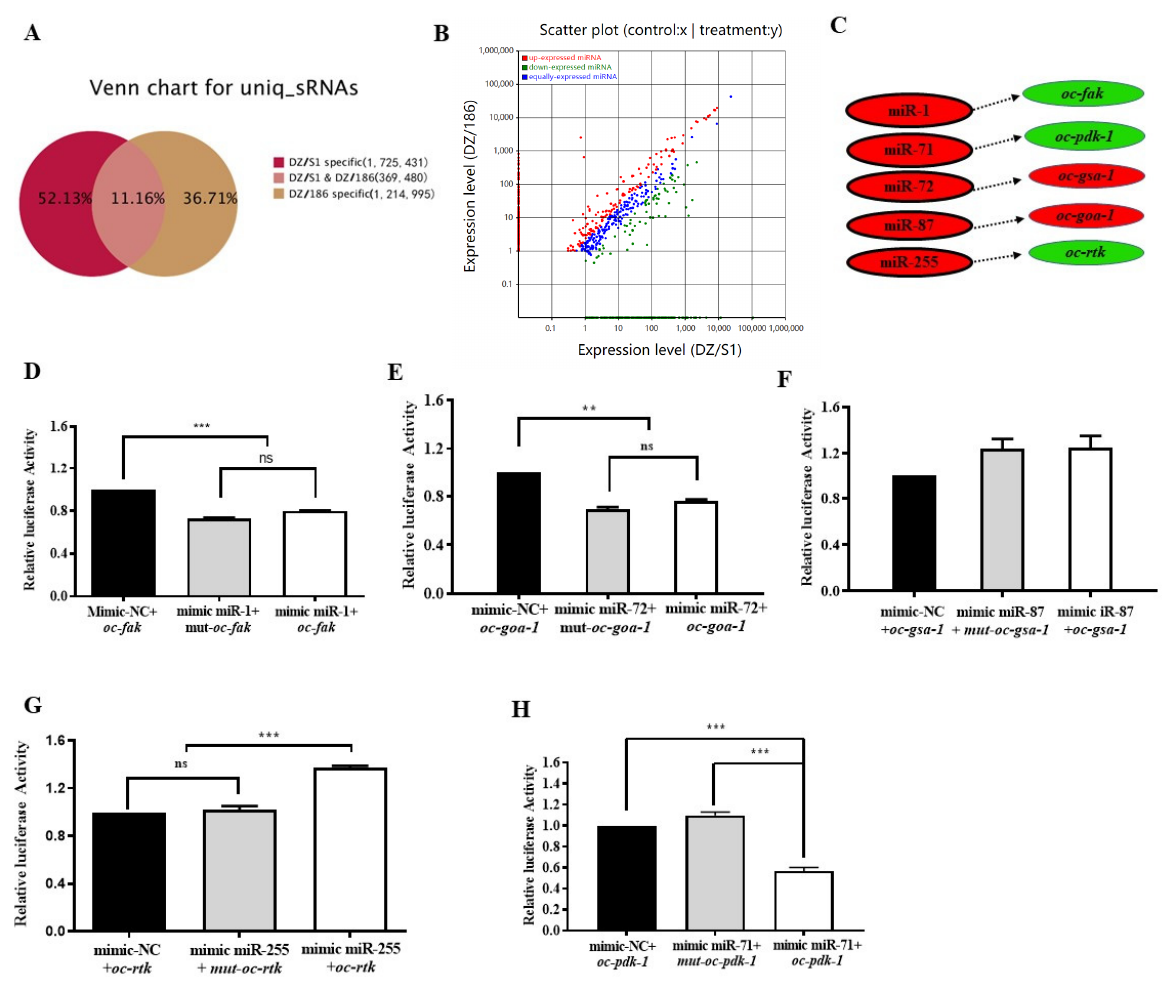
Figure 6. Global comparison analysis of miRNA sequencing data of native vs. non-native monoxenic O. chongmingensis and luciferase activities of related 3 ′ UTR reporter genes. ( A ) Venn chart analysis for uniq-sRNAs of DZ/186 and DZ/S1. ( B ) Analysis of differentially expressed miRNAs between DZ/186 and DZ/S1. ( C ) Prediction model of miRNAs interacting with mRNAs of the five selected genes. Luciferase activities of the oc-fak 3 (cid:48) UTR reporter ( D ), the oc-goa-1 3 (cid:48) UTR reporter ( E ), and the oc-gsa-1 3 (cid:48) UTR reporter ( F ) have no significant difference, respectively, compared with both the miRNA control and the 3 (cid:48) UTR mutant. ( G ) The luciferase activity of the oc-rtk 3 (cid:48) UTR reporter is significantly increased compared with both the miRNA control and the 3 (cid:48) UTR mutant. ( H ) The luciferase activity of the oc-pak-1 3 (cid:48) UTR reporter is significantly decreased compared with both the miRNA control and the 3 (cid:48) UTR mutant. ** p < 0.01; *** p < 0.001; ns, no significant